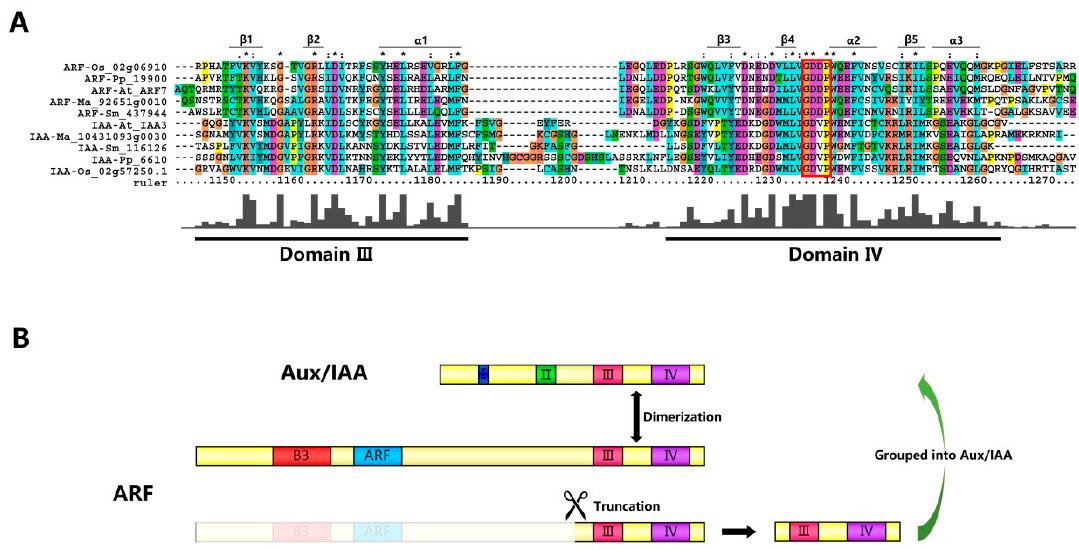
Figure 3. Evolution relationships between representative Aux/IAAs and ARFs. ( A ) Multiple sequence alignment of representative Aux/IAAs and ARFs. Conservative domains III and IV are underlined. The height of the bars indicates the number of identical residues at each position. The β -grasp fold in domains III and IV is marked with “ β 1”, “ β 2”, “ α 1”, “ β 3”, “ β 4”, “ α 2”, “ β 5” and “ α 3”. The part enclosed by the red line is the conservative motif site “GDDP” in ARFs and “GDVP” in Aux/IAAs. The asterisk (*), colon (:), and dot (.) represent different conservative level from high and low; ( B ) Putative model for generating Aux/IAAs from truncated ARFs. Some truncated putative Aux/IAA genes were derived from truncated ARF genes, which only compose the Aux/IAA domain (domains III and IV), but lack their typical domains I and II.